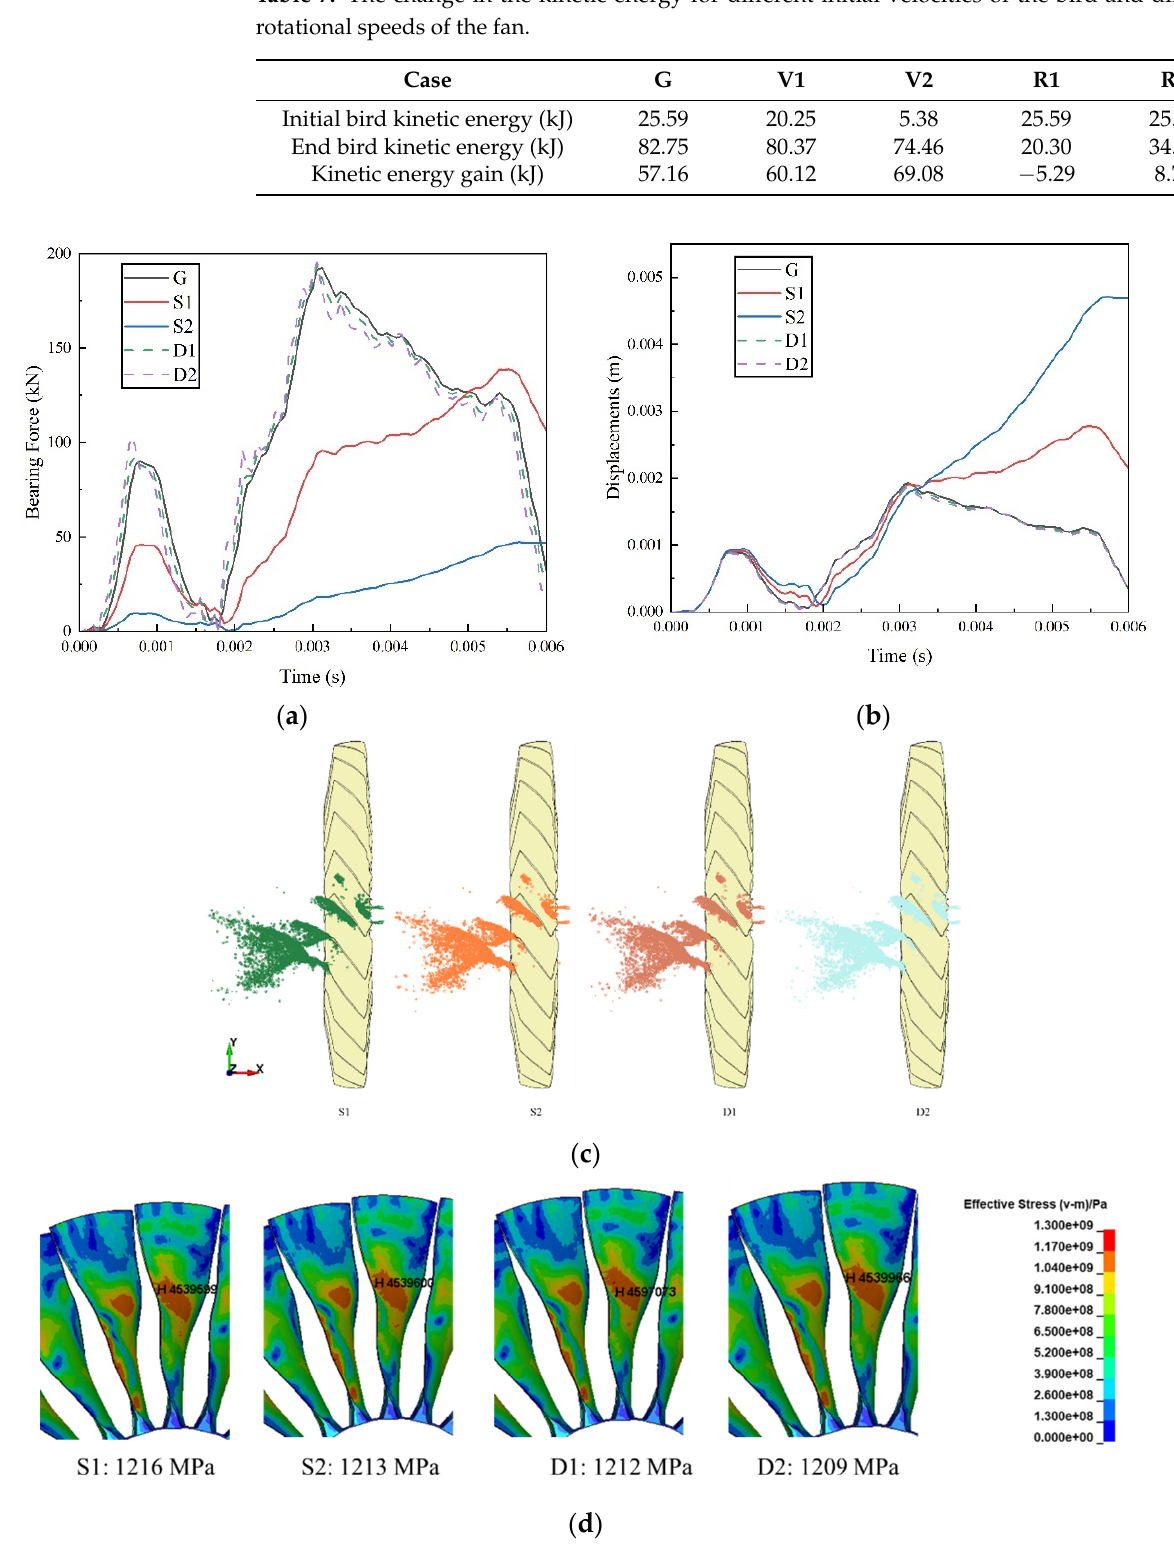
Figure 11. Effect of changing the stiffness and damping of the fan hub support system: ( a ) the bearing force vs. time; ( b ) displacement of the axis vs. time; ( c ) bird deformations; and ( d ) the von Mises